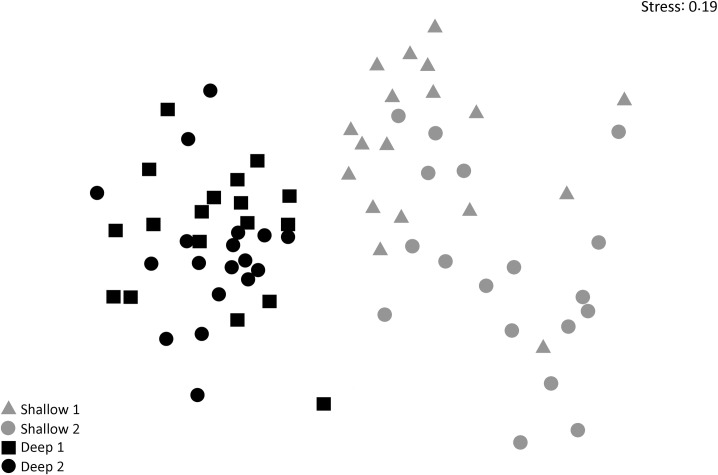
Multidimensional scaling (MDS) comparing reef fish communities in shallow and deep reefs in northeastern Brazil.